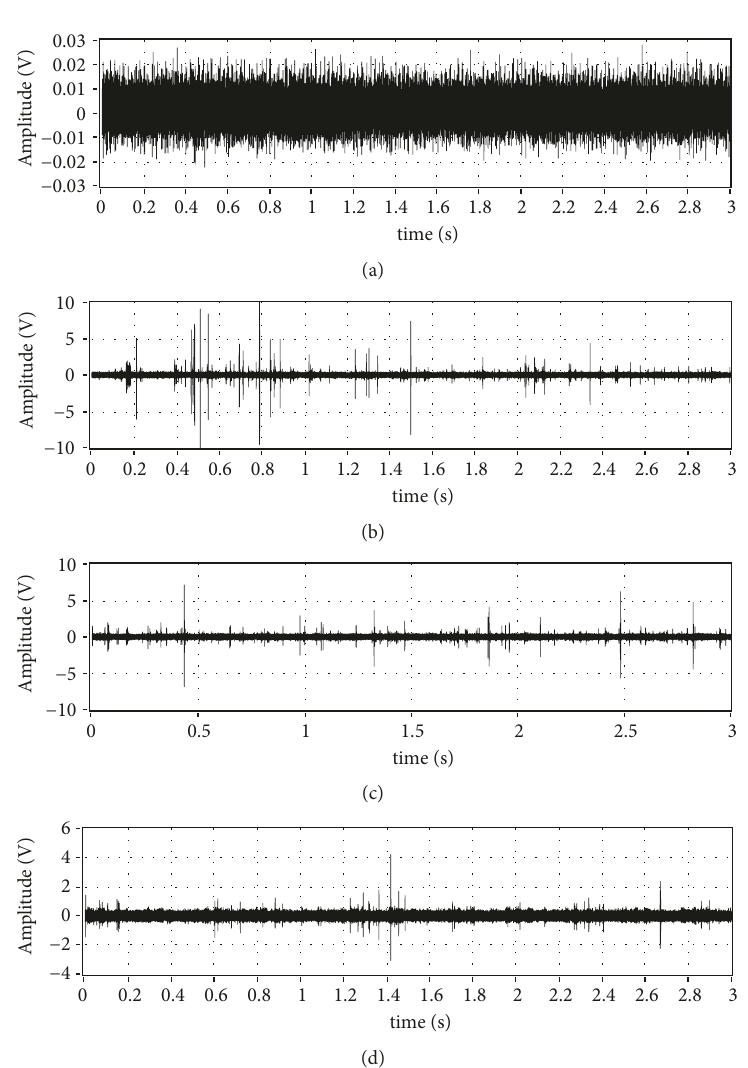
Figure 8: Time domain waveforms of AE signal: (a) machine idling; (b) initial tool wear; (c) normal tool wear; (d) severe tool